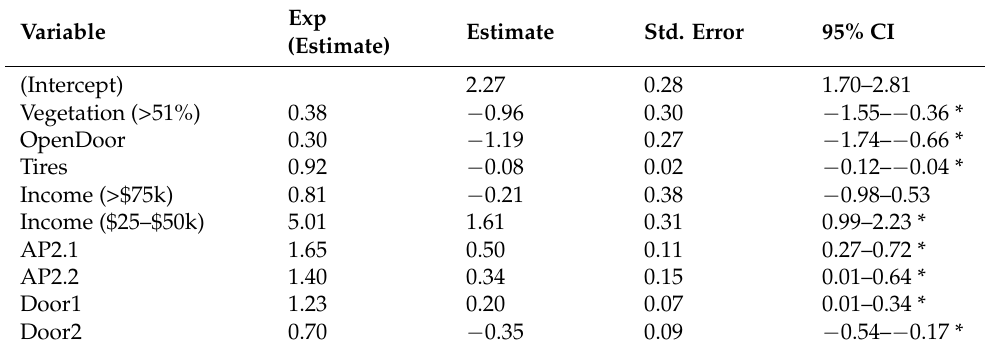
Table 7. Main effects statistics for the best fit generalized linear model (NB1) for outdoor female Ae. aegypti abundance in South